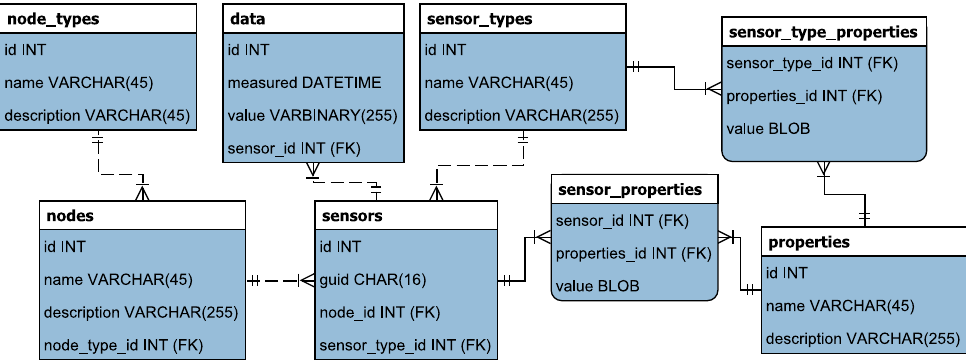
Figure 3. ER model of the local sensor node